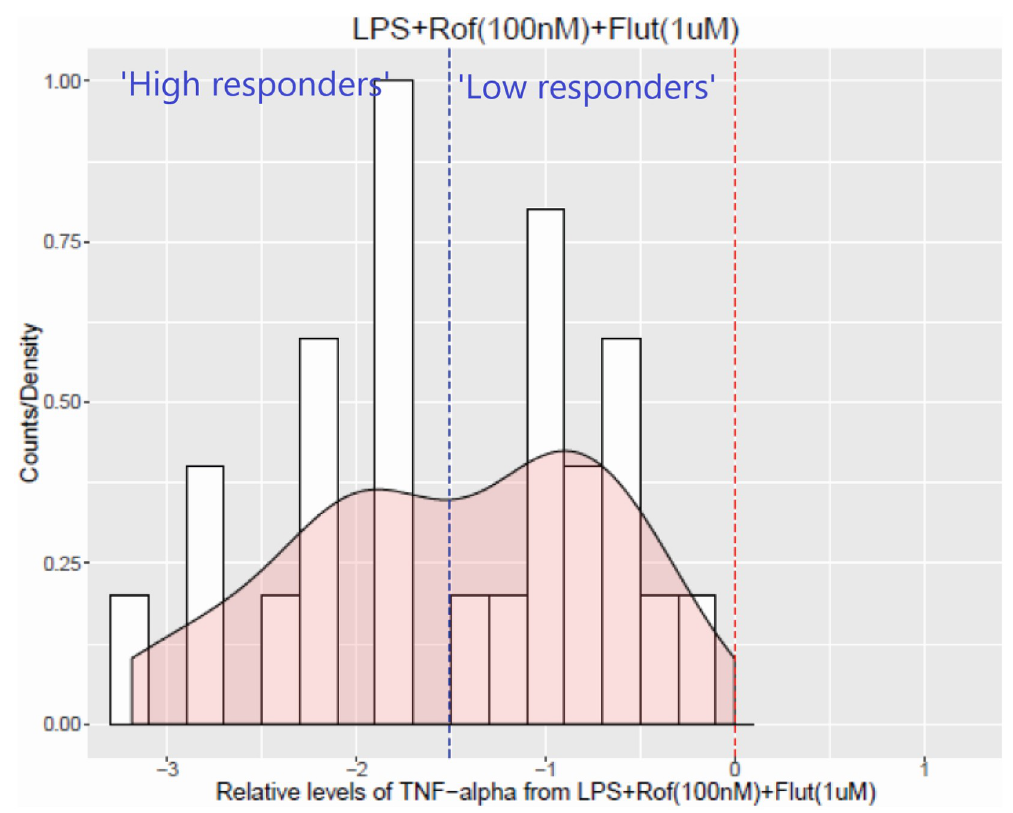
Fig 3. Visualisation of patient-to-patient changes in the relative levels of TNF α after combination treatment of roflumilast (100 nM) and fluticasone (1 μ M). The density plot shows histogram bin counts (number of times a value falls within a given bin) as white bars as well as a smooth density in pink of the log2 ratios of TNF α release from biopsies treated with roflumilast plus fluticasone, relative to those treated with DMSO (which also includes LPS and the vehicle control), across all 25 patients. The average level in the treated biopsies is denoted by a blue dashed vertical line and the red dashed line denotes zero as this is the average level in control biopsies.